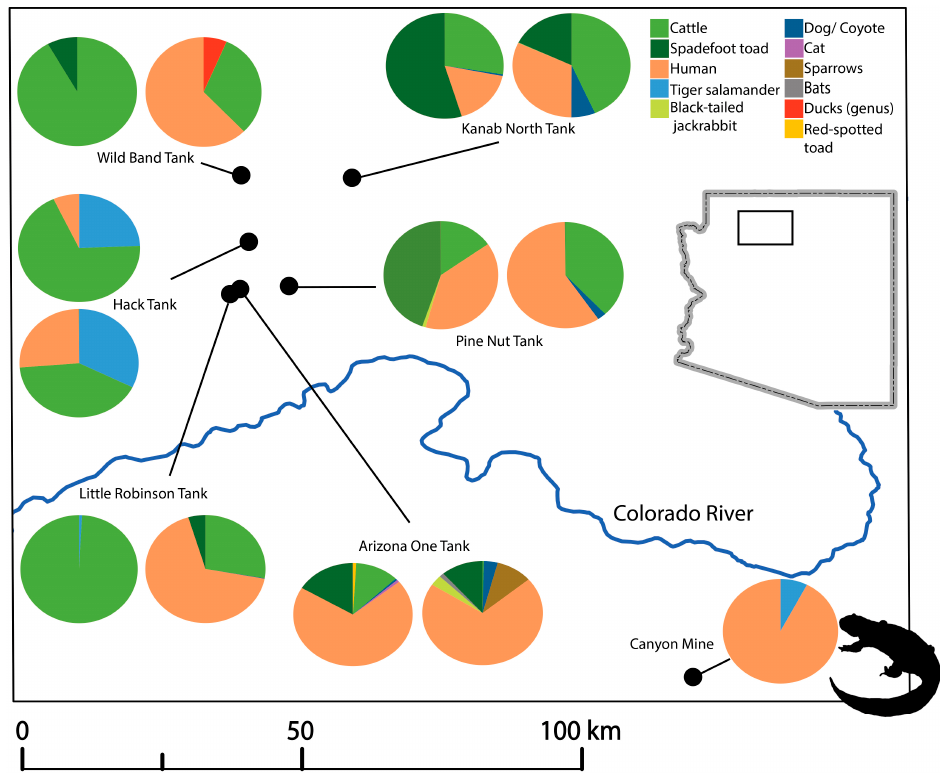
Figure 3. Pie charts show percentage of total reads per site for each taxa for the 16S assay. The left or top pie chart is the earlier date sampled, and the right or bottom chart is the later date sampled for each site. Figure only shows taxa that are 0.3% or greater of the total read counts for that site. See Supplemental Tables S2 and S3 for all taxa reads per site. (Salamander image: Matt Reinbold—picture; Michael Keesey—modification; https://creativecommons.org/licenses/by-sa/3.0/)